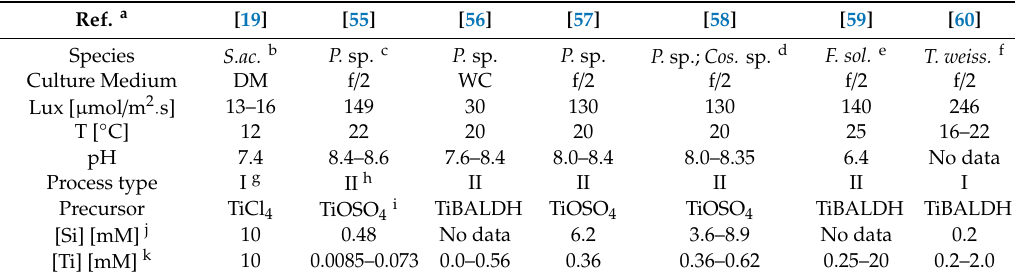
Table 1. Summary of methods used for the metabolic insertion of titanium ions to diatomaceous biosilica. Table1. Summaryofmethodsusedforthemetabolicinsertionoftitaniumionstodiatomaceousbiosilica.